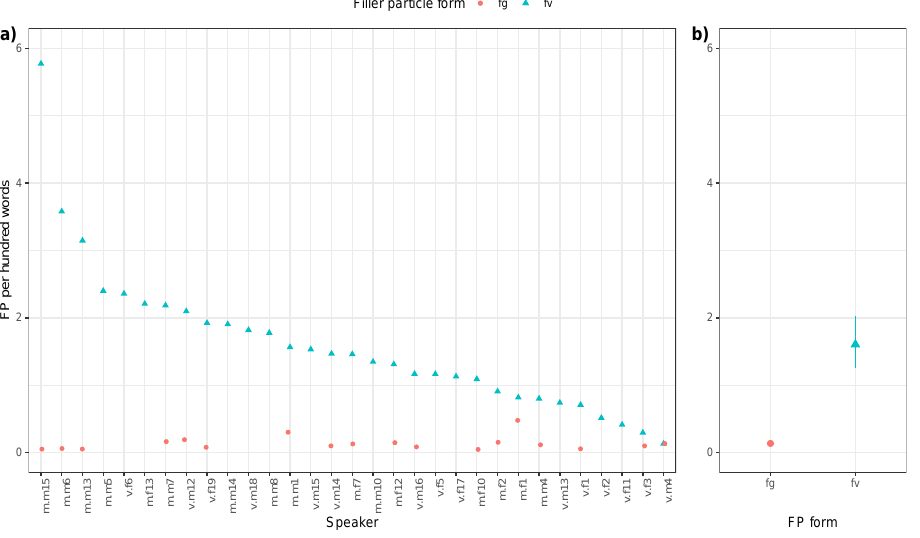
Figure 12. ( a ) Filler particle forms ( fg = glottal, fv = vocalic) per hundred words per speaker and ( b ) bootstrapped confidence intervals (95%). The first character (m/v) indicates the main or videocall subcorpus.